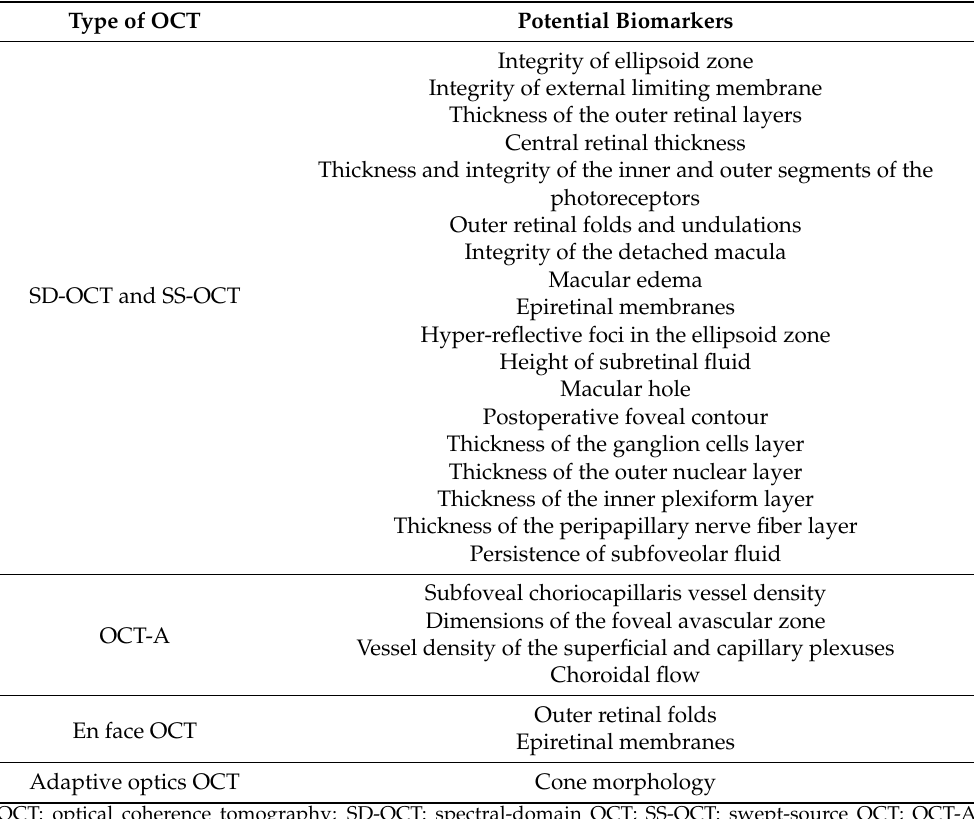
Table 6. Potential